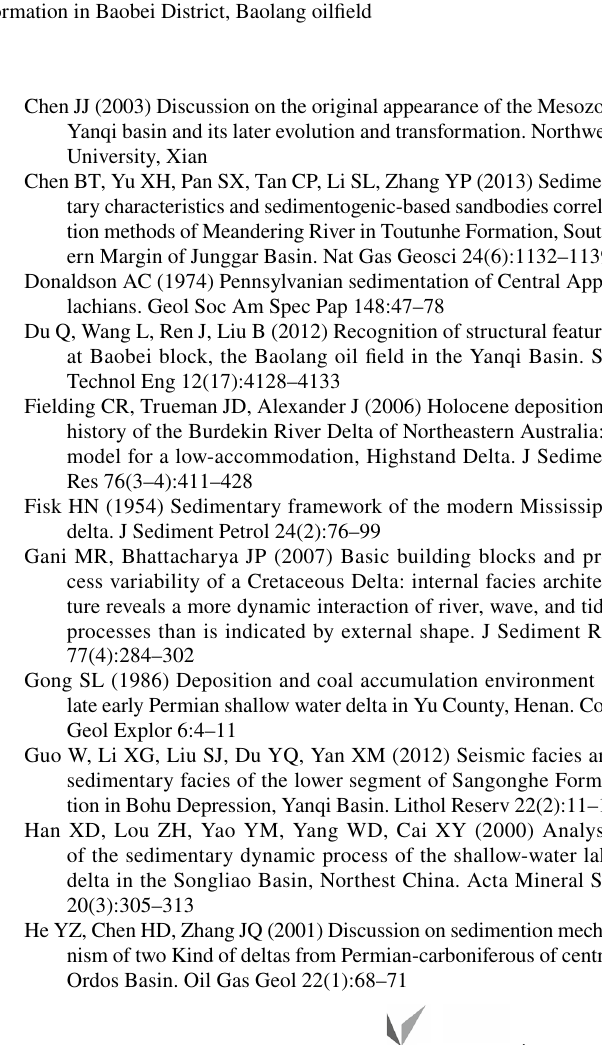
Fig. 12 Sedimentary model of III oil-bearing interval of Sanggonghe Formation in Baobei District, Baolang